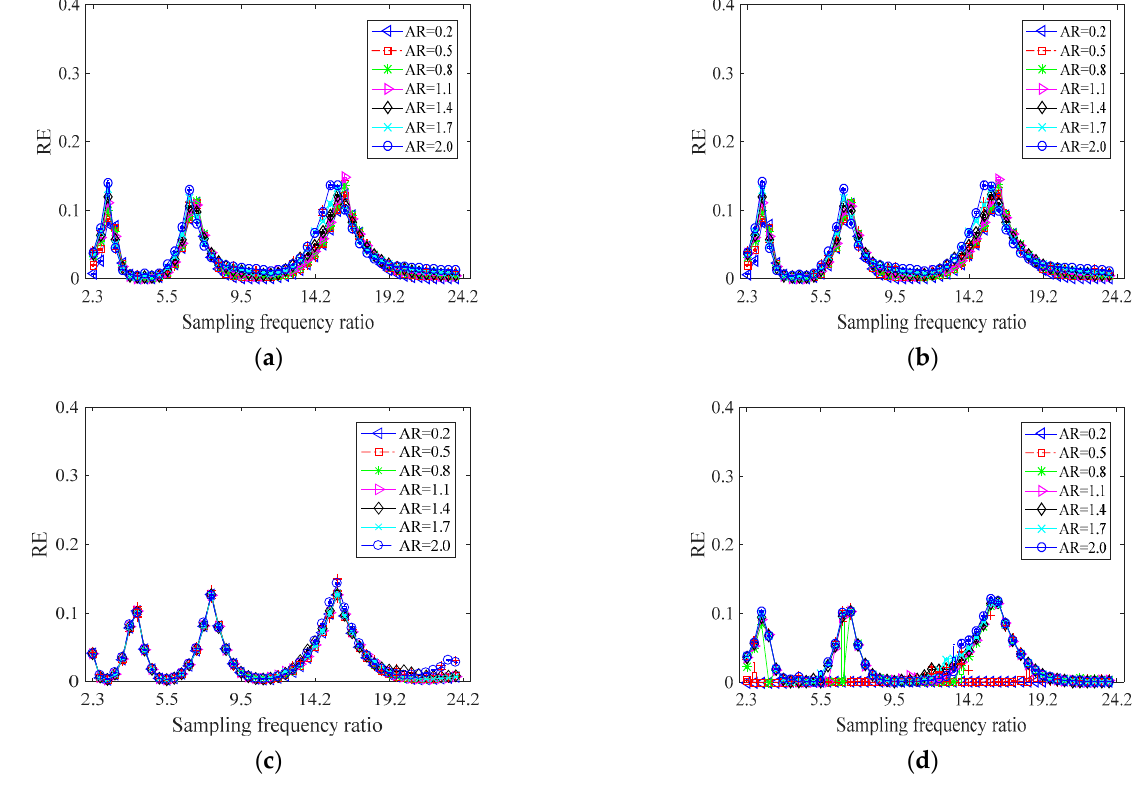
Figure 6. RE of the sinusoidal component in the original signal for the four noise-assisted EMD algorithms: ( a ) EEMD; ( b ) CEEMD; ( c ) CEEMDAN; ( d ) ICEEMDAN.